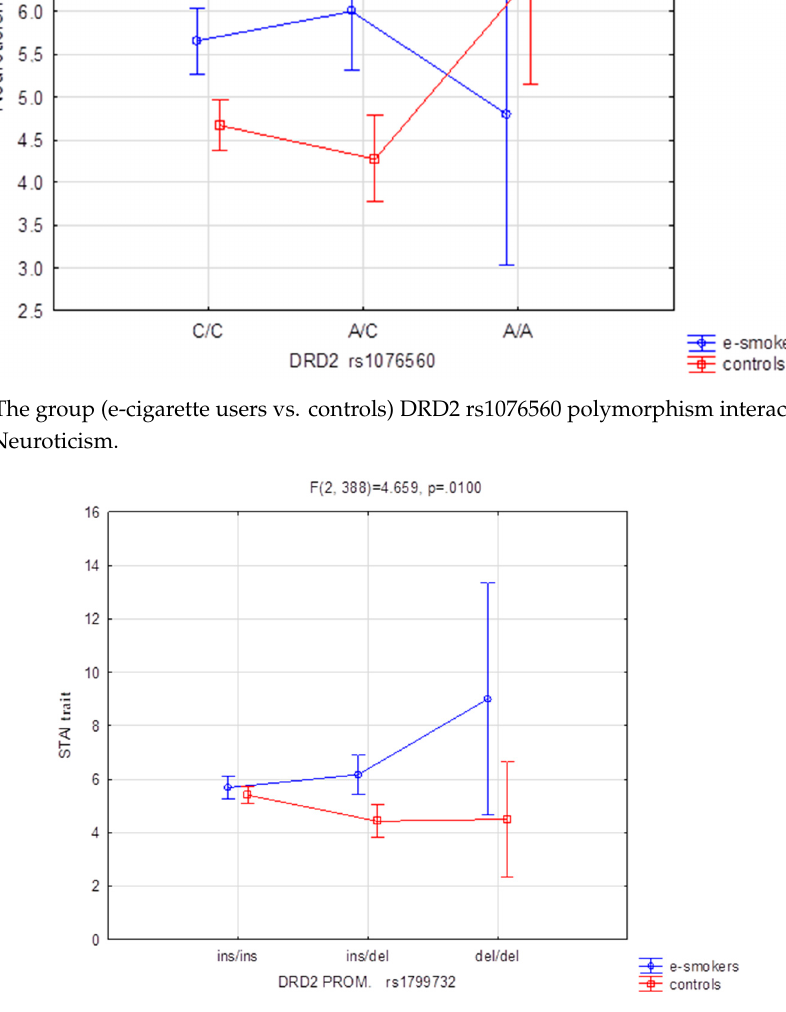
Figure 2. The group (e-cigarette users vs. controls) DRD2 rs1799732 polymorphism interaction for the STAI